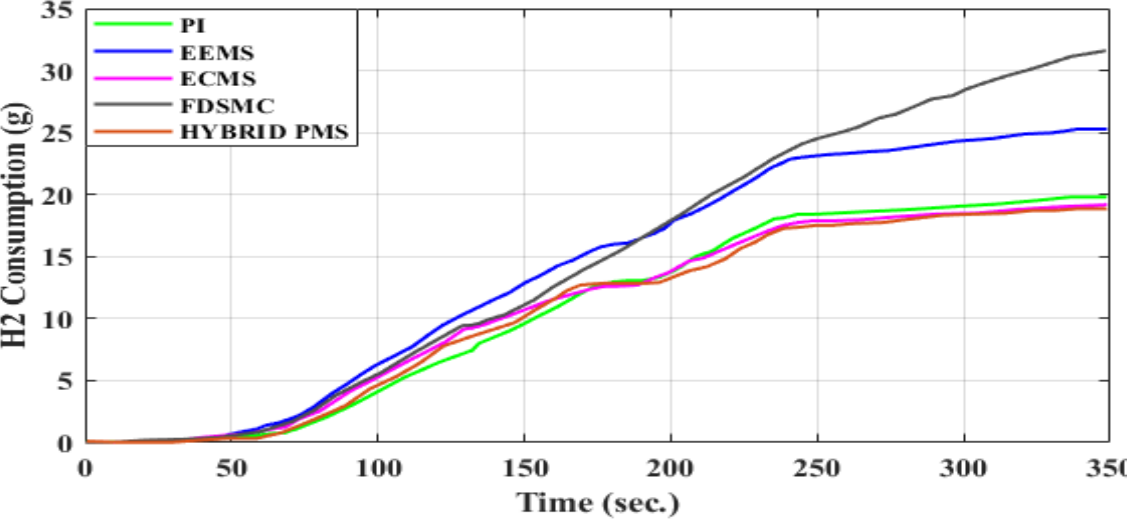
Figure 16. Hydrogen consumption in grams for studied approaches (WLTP — Class 3 Drive Cycle).